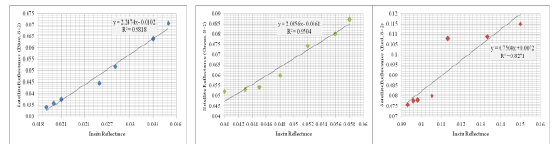
Figure 2. Variations of means-of-spill signatures from 7 occurrences against spill signatures of NASA (Clark , et al. , 2010). Signatures of Sentinel-2 MSI represents in blue, green and red spectral